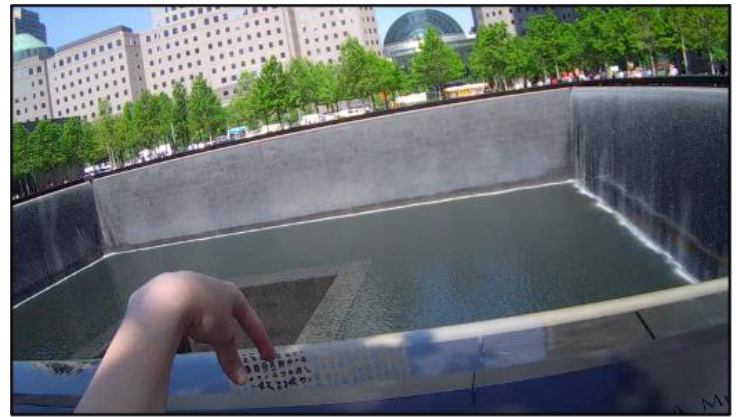
Figure 5. Participant reflecting at the 9/11 National Memorial.